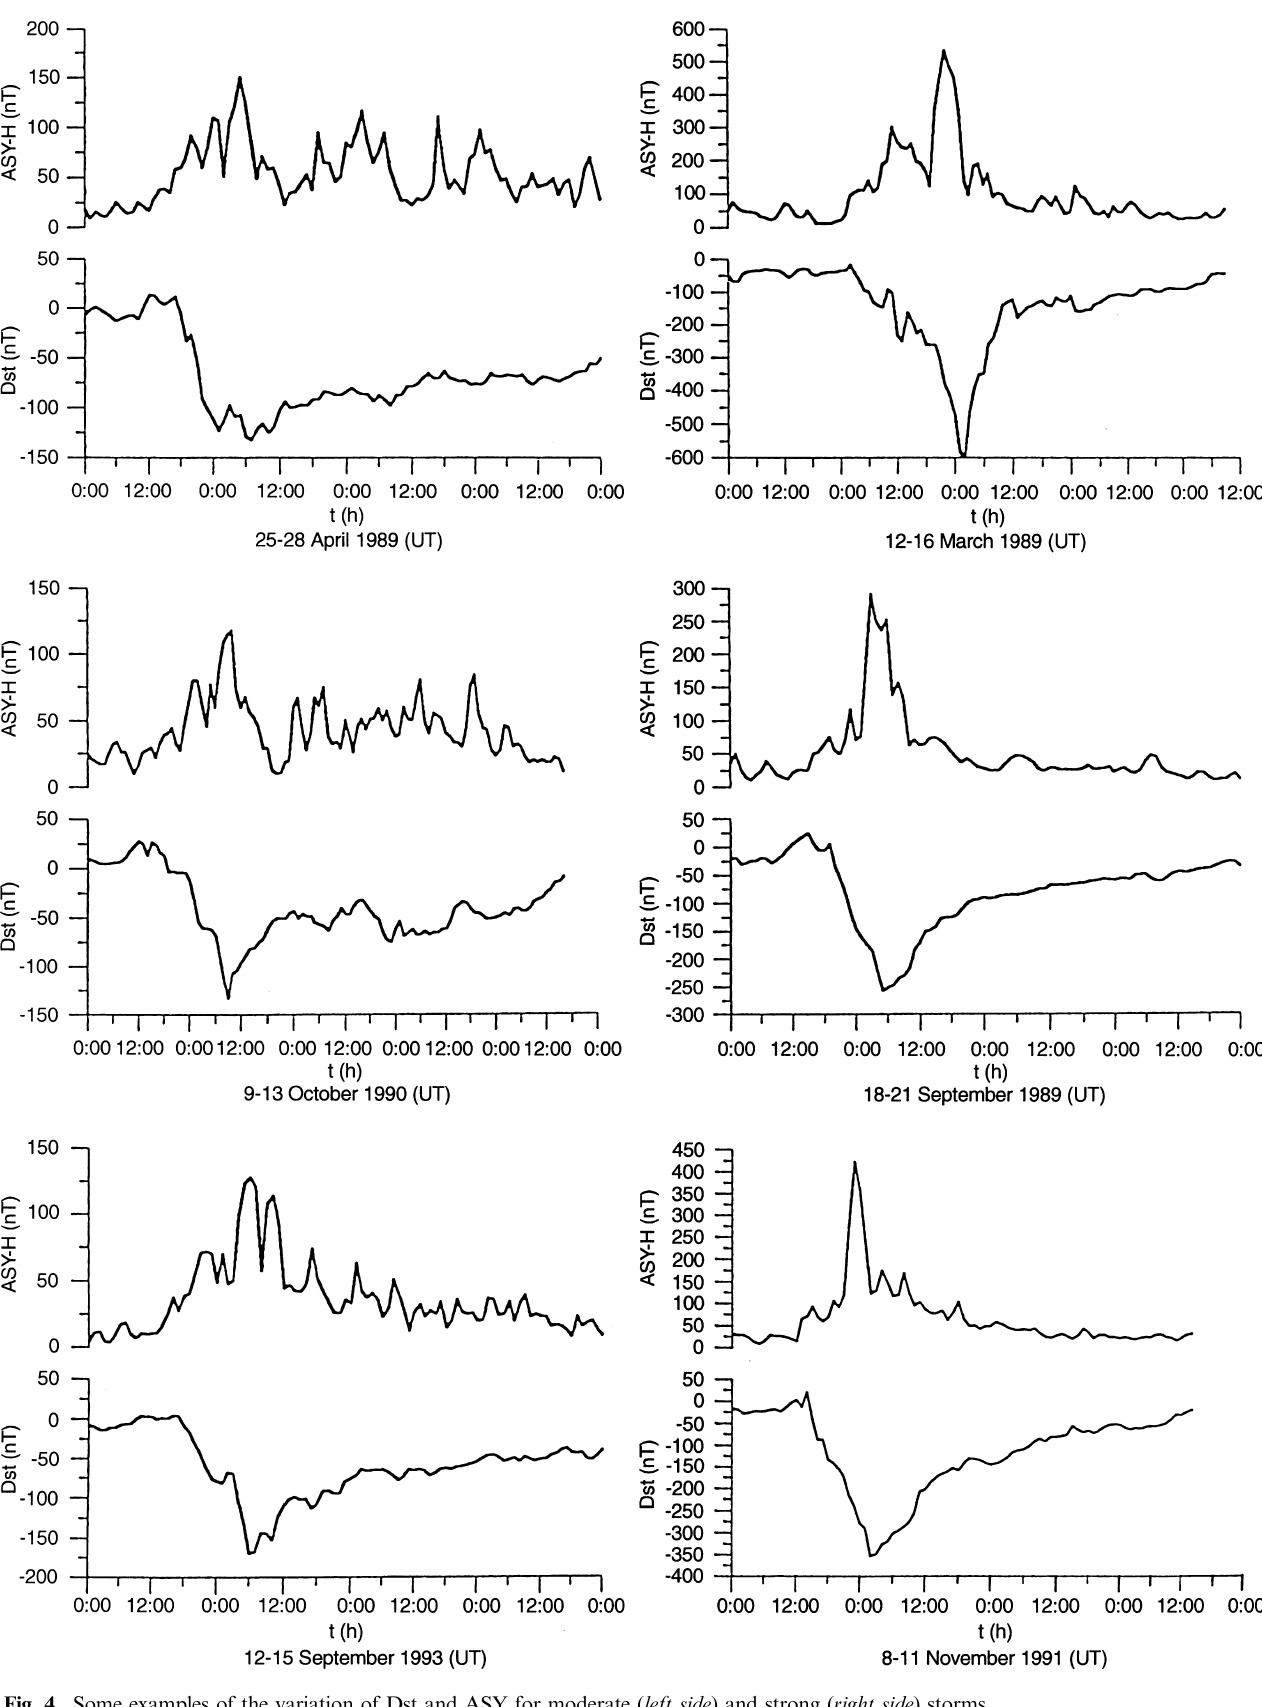
Fig. 4. Some examples of the variation of Dst and ASY for moderate ( left side ) and strong ( right side )